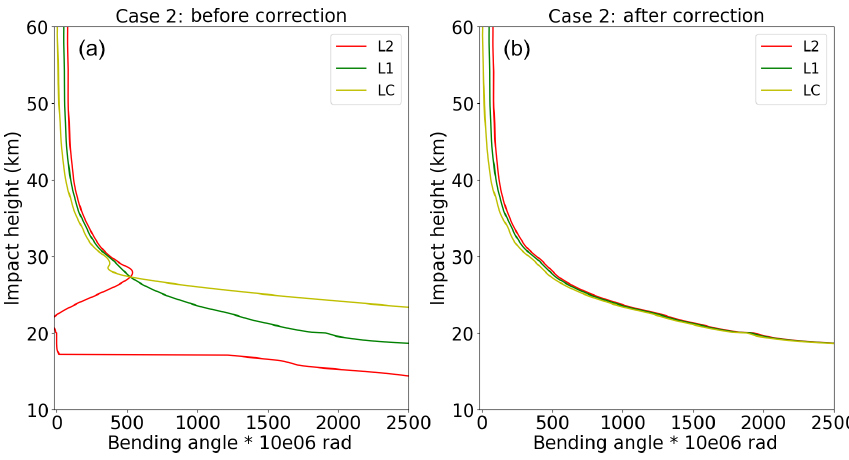
Figure 6. The same as Fig. 5 but for case